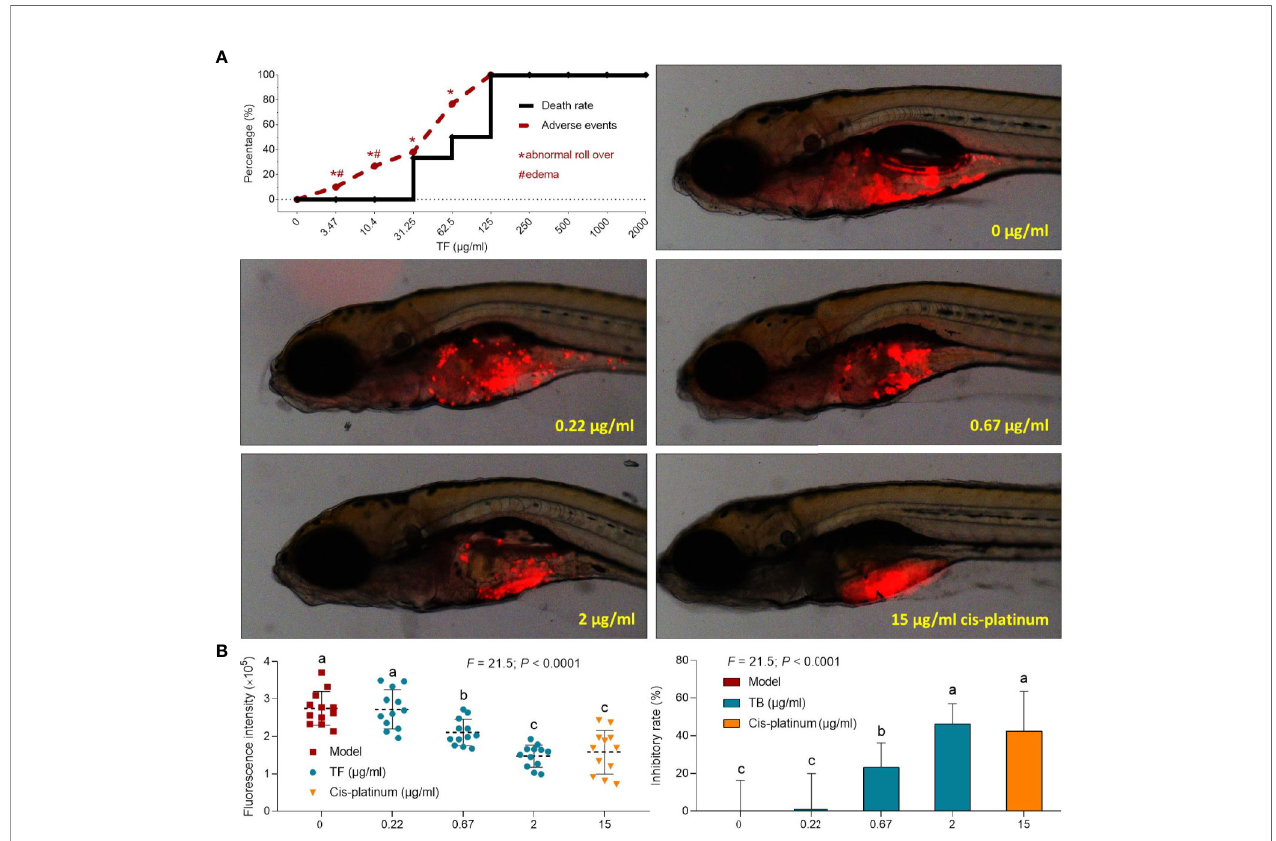
FIGURE 3 | Mortality and adverse events of larval zebra fi shes induced by thea fl avin (TF) and observation of larval zebra fi shes xenotransplanted with A375 cells with treatment of TF or cisplatin (A) as well as the fl uorescence intensity and inhibitory rates of TF (B) . Fluorescent area in red represents the A375 cell mass. By means of LSD multiple comparisons, data (mean ± SD) with same lowercase letter (a vs. a; c vs. c) indicate no signi fi cant difference between each other, while data with different letters (a vs. b vs. c) indicate signi fi cant difference with each